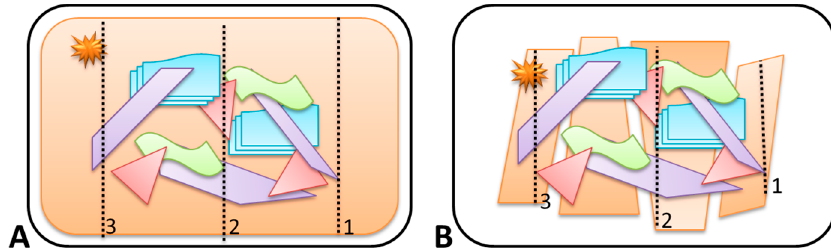
Figure 1. Schematic representation of the general lay-out of the burn experiments. IL was applied along three parallel traces, from right to left as indicated by the numbering. In the schematic drawing, the primary substrate is a carpet ( A ) or wood flooring of laminate ( B ). Secondary substrates are indicated in purple (wood), green (textile), blue (paper), and plastic (red).